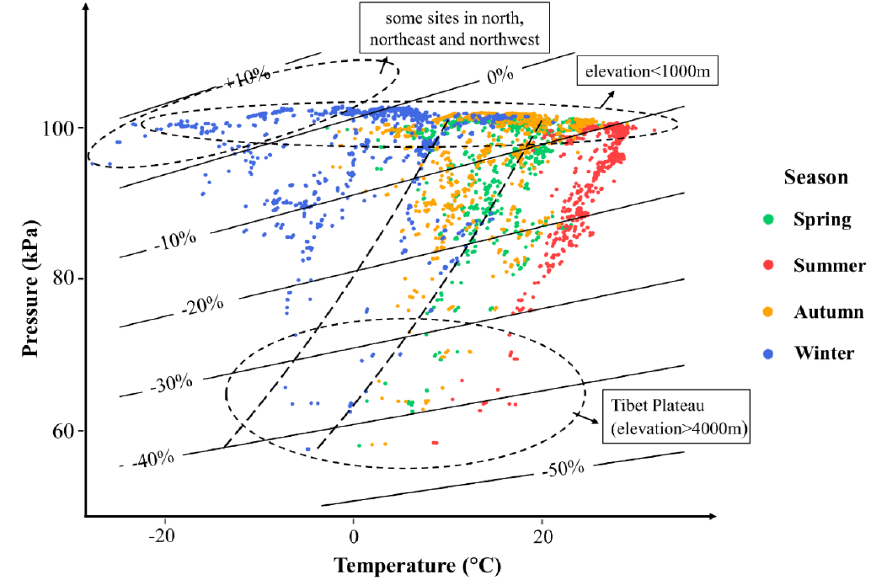
Figure 3. Combined effects of atmospheric temperature and pressure on the shift of reported concentrations of particulate matter (PM 2.5 or PM 10 ) caused by the measurement modification. The solid contour lines indicate shifted percentages of reported concentrations. Each dot represents a seasonal average data point at a monitoring site from September 2017–August 2018. Different colors denote measurements in spring (March, April, and May), summer (June, July, and August), autumn (September, October, and November), and winter (December, January, and February). Dots from regions of interests are circled with dashed ellipses.